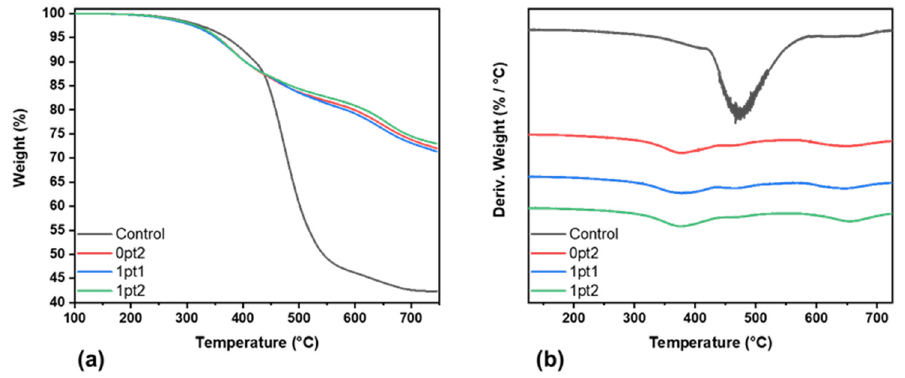
Figure 4. Thermal stability of pristine samples: ( a ) TGA curves and ( b ) DTGA curves magnified. CTE values were 266 ppm K − 1 for the Control, 250 ppm K − 1 for 0pt2, 203 ppm K − 1 for 1pt1, and 207 ppm K − 1 for 1pt2. Along with the original manufacturer of Sylgard 184 claim-